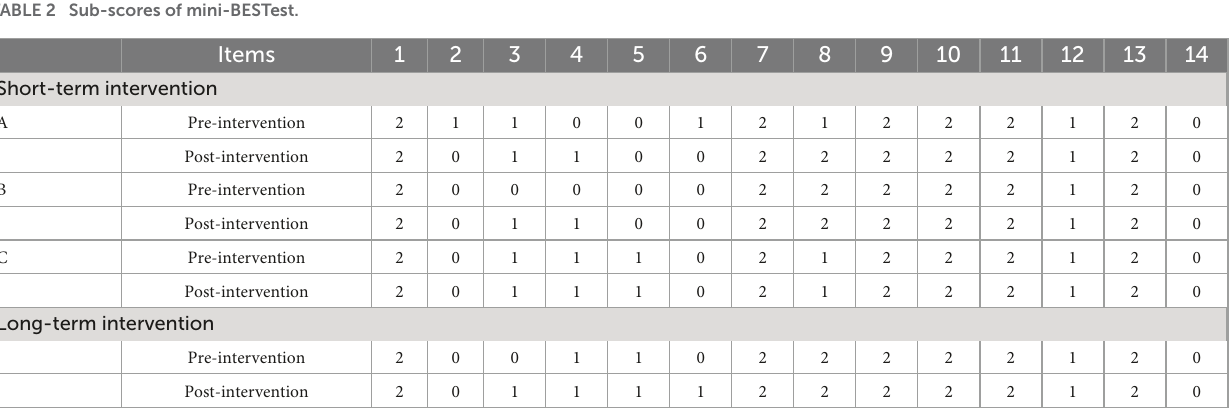
TABLE 2 Sub-scores of